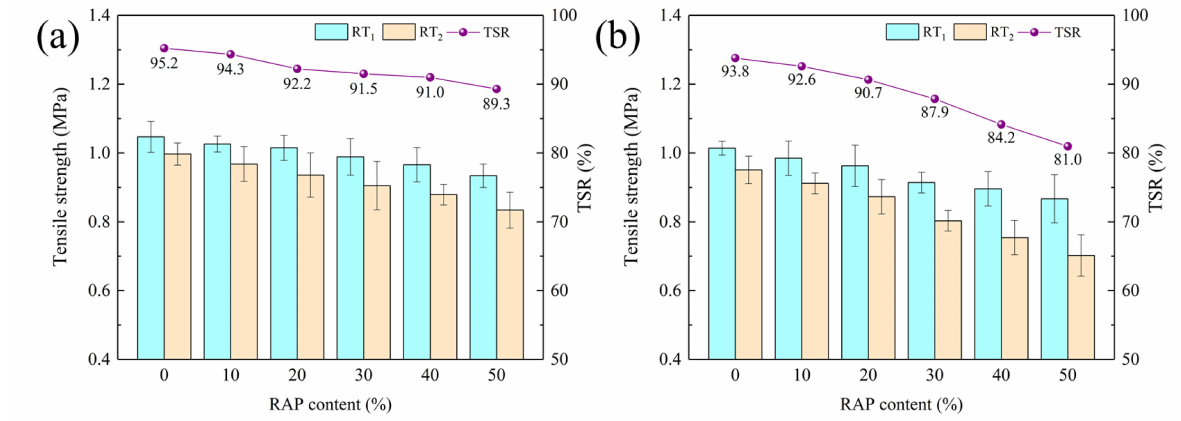
Figure 5. TSR results of RAM: ( a ) steel slag; ( b ) basalt.